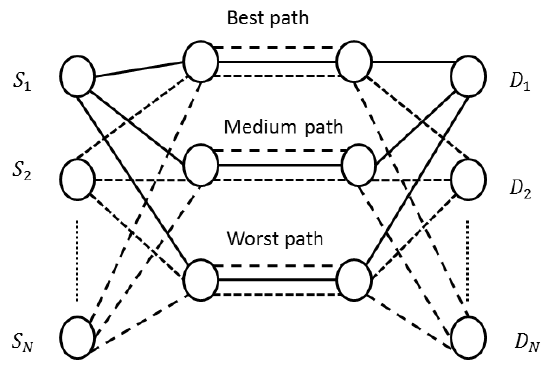
Figure 4. Proposed framework to send the video